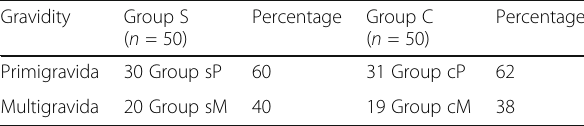
Table 1 Distribution of patients in two groups according to parity